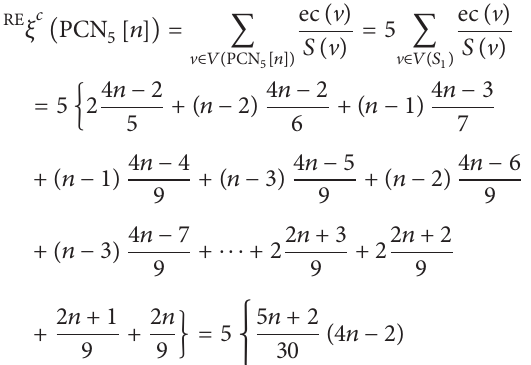
According to the vertex classification and distance